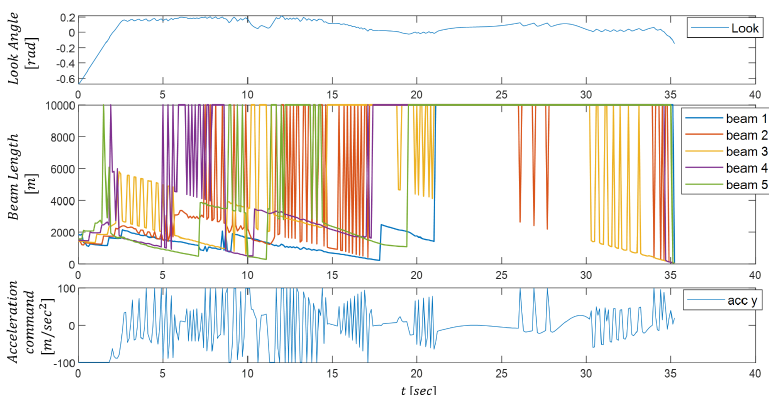
Figure 12. Trajectories of the look angle, beam length, and acceleration command.